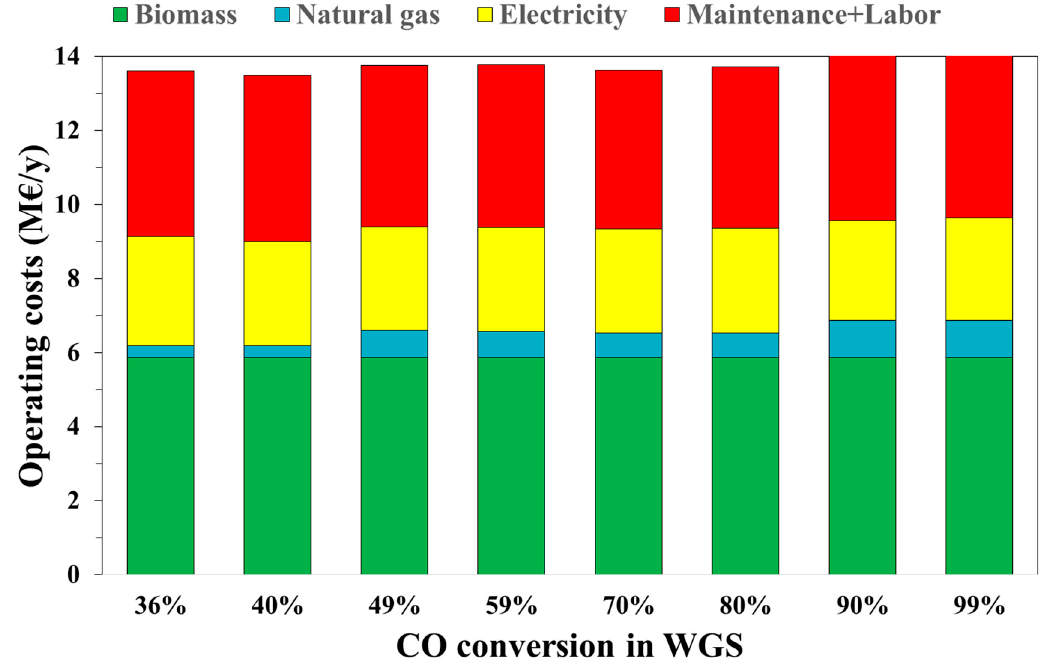
Figure 6. Operating costs varying with the WGS conversion.